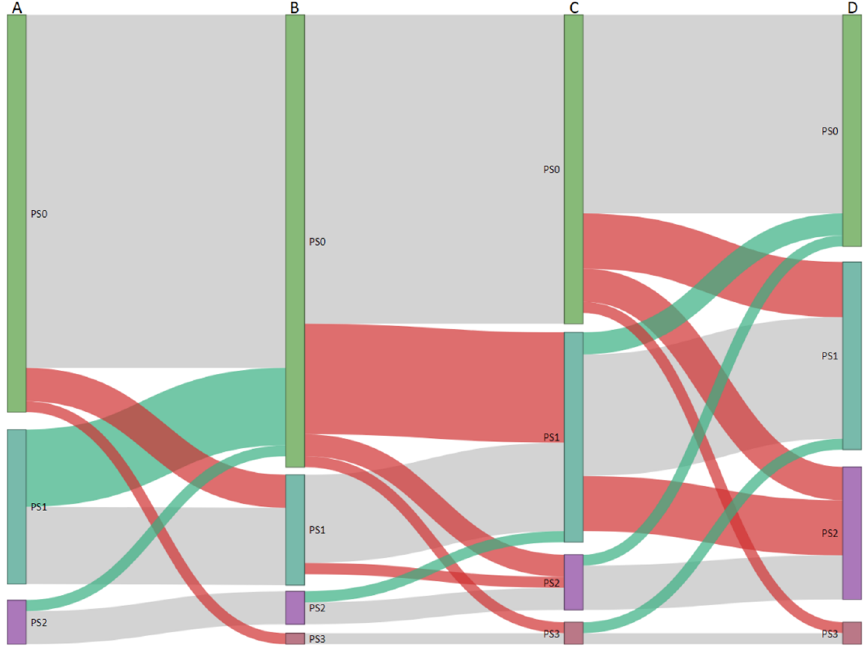
Figure 2. Sankey diagram demonstrating changes in performance status from initial diagnosis (A), after primary operation (B), before re-operation (C), and 6 months after re-operation (D). The length of the nodes and links between nodes are proportional to the number of patients. Red links indicate a worsening of performance status. Green links indicate improved performance status. Grey links indicate no change in performance status.